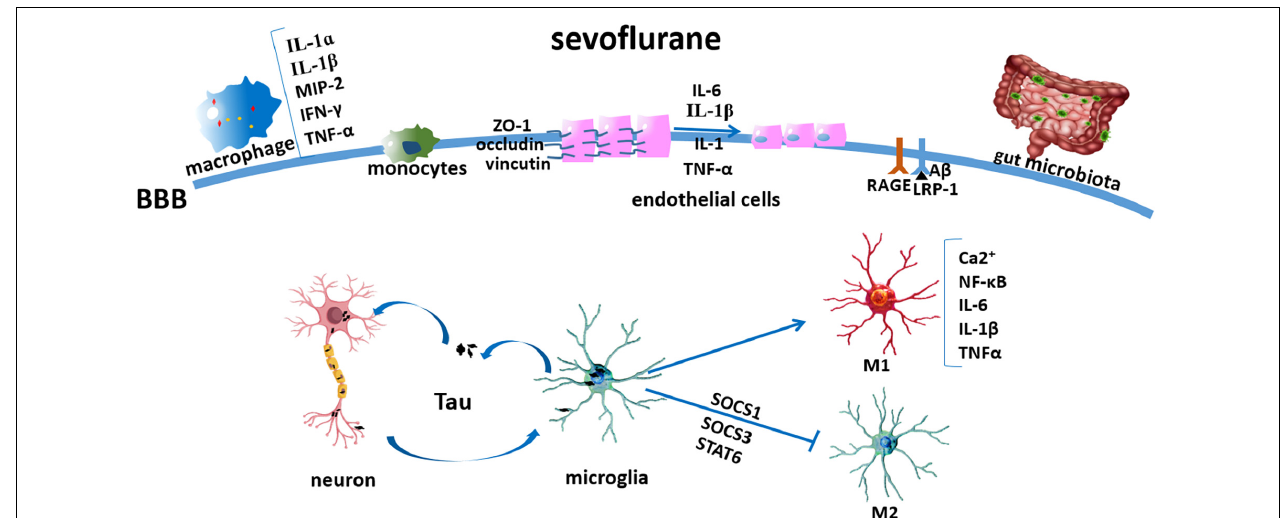
FIGURE 1 | Sevoflurane modulating microglia and peripheral factors involved in neuroinflammation. Sevoflurane induced Tau transfer from the neurons to the microglia, thereby activating it to produce neurotoxic inflammatory molecules and cytokines, such as IL-1 β and TNF- α ; later, Tau can be phagocytized and secreted extracellularly and transmitted into the neuron again; sevoflurane induced microglia polarized into M1 activation via the NF- κ B signaling pathway and inhibited its M2 activation by mediating SOCS1, SOCS3, and STAT6; sevoflurane induced macrophage inflammation, as shown by IL-1 α , IL-1 β , MIP-2, IFN- γ , and TNF- α increases; sevoflurane flattened the endothelial cell luminal surface and enlarged its perivascular spaces; and cytokines (IL-1 β , IL-1, TNF- α , and IL-6) induced depression and redistribution of BBB adherens junction proteins (ZO-1, occludin, and vinculin); sevoflurane increased RAGE and decreased IRP-1 expressions; sevoflurane decreased intestinal microbiome abundance and diversity.